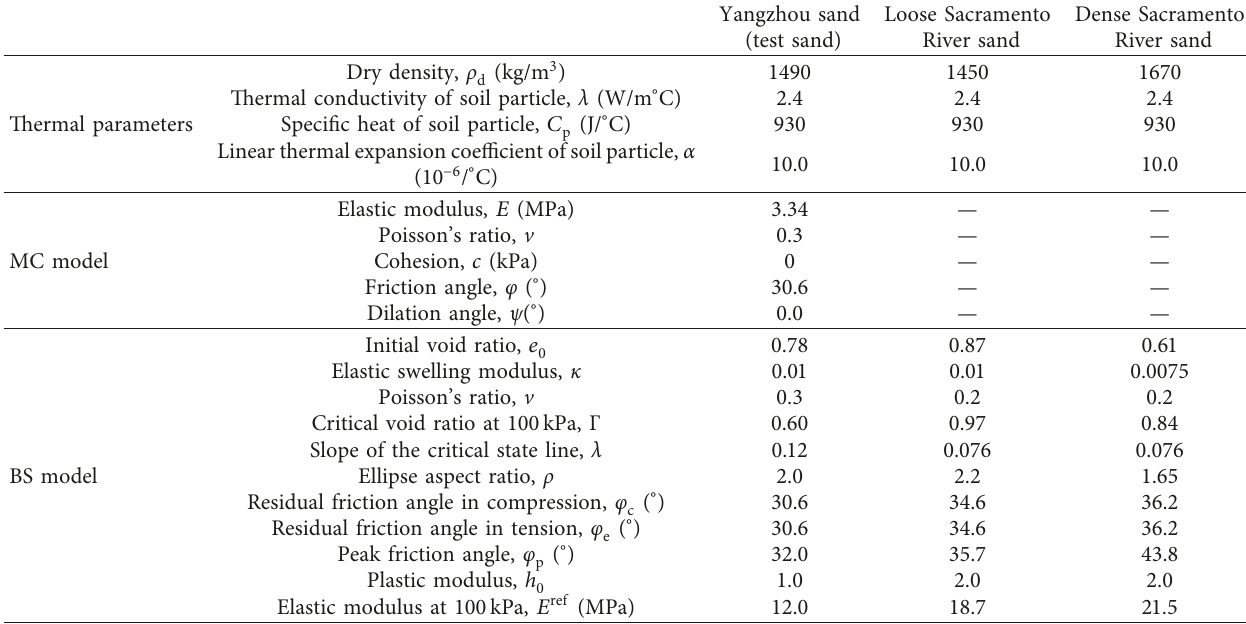
Table 2: Material parameters of the